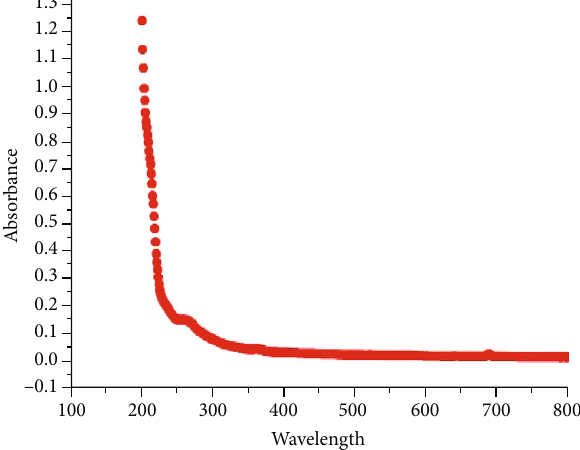
Figure 5: UV-Vis spectra of prepared CoF